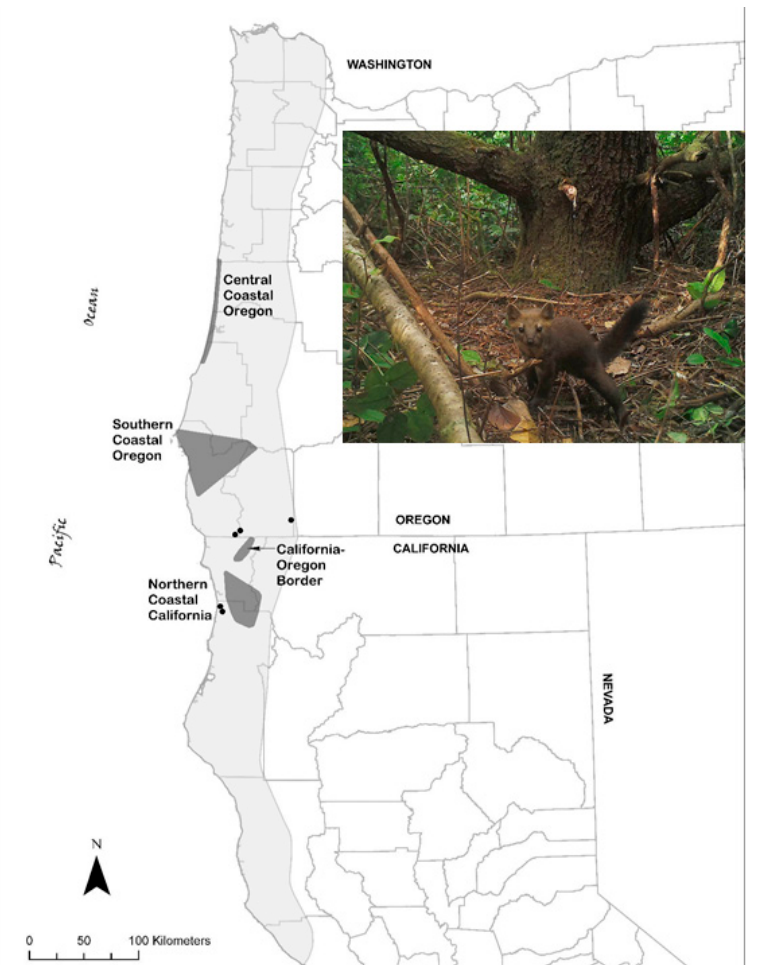
Figure 2. Historical range of the coastal marten indicated by light grey, with the 4 currently extant populations delineated by darker polygons. Black circles indicate single detections that do not constitute a population. Fires have been an important historical disturbance throughout the species’ range, as fire creates structural features (e.g., snags, hollow trees, resting platforms, down logs) conducive to suitable habitat. Major fires have traditionally been infrequent [66], however, and more severe fires may eliminate structural features and increase the abundance of predators or competitors, resulting in degraded marten habitat [67,68]. Warmer and drier conditions are projected for this coastal region [69,70], which may lead to more frequent large fires and reduced habitat suitability. Future scenarios incorporated levels of altered fire cycles along with other disturbance regimes influenced by climate change. Map from [71]; photo by U.S. Forest Pacific Northwest Research Station and Oregon State